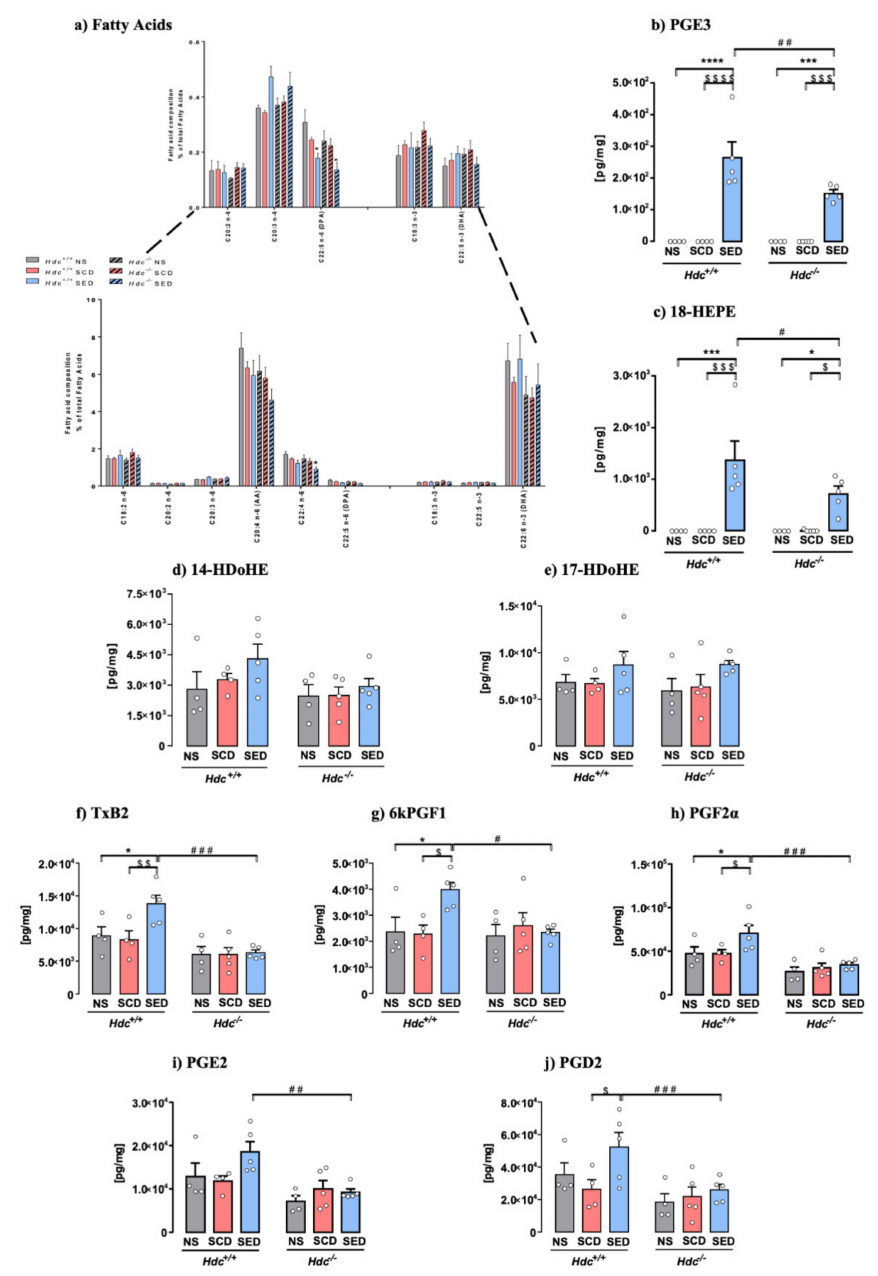
Figure 3. Fatty acid and oxylipins composition of hippocampal tissue sorted from Hdc +/+ and Hdc − / − mice. ( a ) Effect of stress and the enriched diet on total expression of fatty acids. Inset: higher magnification of low expressed fatty acids. ( b – j ) Effect of stress and the enriched diet on EPA-, DHA- and AA derived oxylipins in the hippocampus of Hdc +/+ and Hdc − / − mice. Hippocampal content of EPA metabolites PGE3 ( b ) and 18-HEPE ( c ). Tissue content of DHA metabolite 14-HDoHE ( d ) and 17-HDoHE ( e ). ( f – j ) Effect of stress and the enriched diet on AA metabolites. Data are expressed as means ± S.E.M. of 4–5 samples per experimental group **** p < 0.0001; *** p < 0.001, * p < 0.05 vs respective NS mice; $$$$ p < 0.0001, $$$ p < 0.001, $$ p < 0.01, $ p < 0.05, vs. respective SCD mice; ### p < 0.001, ## p < 0.01, # p < 0.05 vs same treatment of different genotype. NS = non-stressed; SCD = stressed, control diet; SED = stressed, enriched